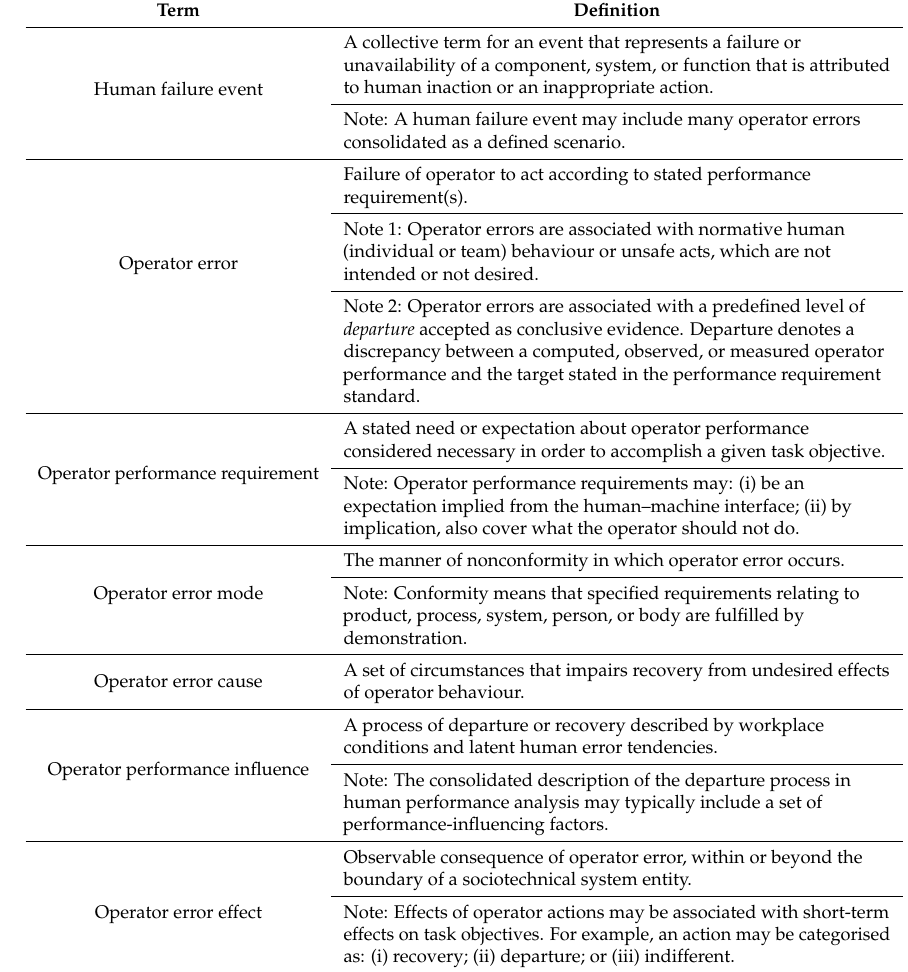
Table 2. Terminology relevant to task analysis of offshore drilling activity (adapted from